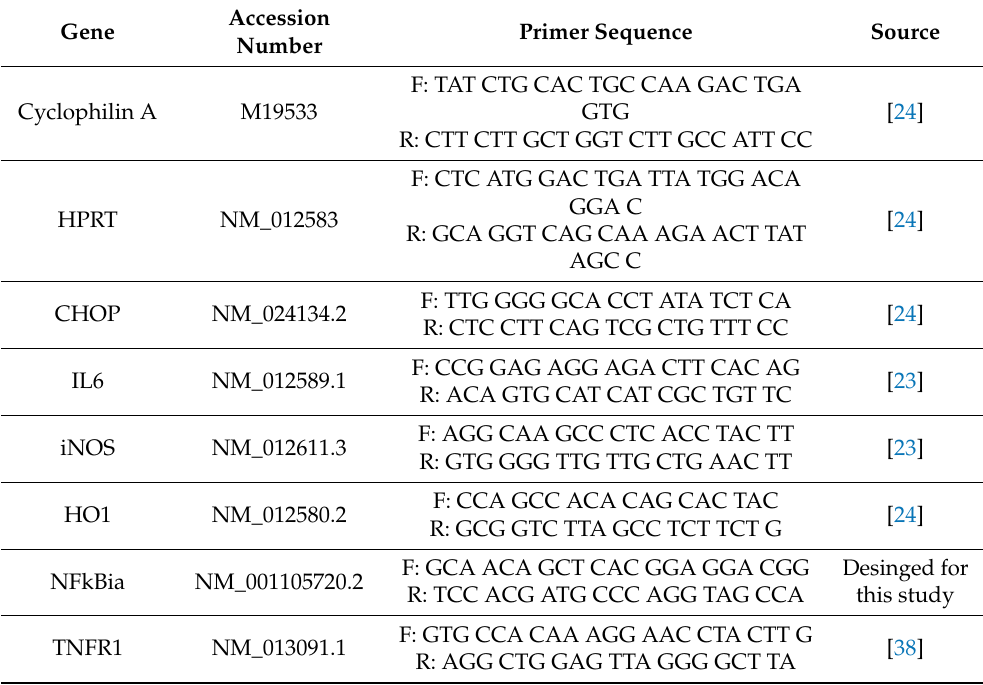
Table A1. Sequences for primers used for measuring gene expression. HPRT: hypoxanthine-guanine phosphoribosyl transferase; CHOP: CCAAT/enhancer-binding protein homologous protein; IL6: interleukin 6; iNOS: inducible nitric oxide synthase; HO1: heme oxygenase 1; NFkBia: NFkB inhibitor alpha; TNFR1: tumor necrosis factor receptor 1. Accession Primer Sequence Source Gene Number F: TAT CTG CAC TGC CAA GAC TGA Cyclophilin A M19533 GTG [24] R: CTT CTT GCT GGT CTT GCC ATT CC